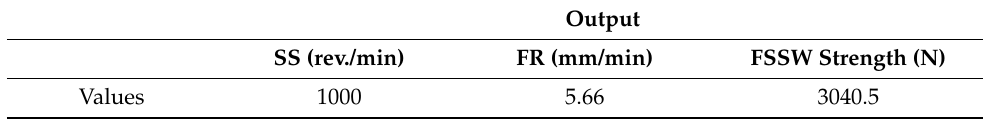
Figure 19. Welding strength variation with spindle speed and feed rate.